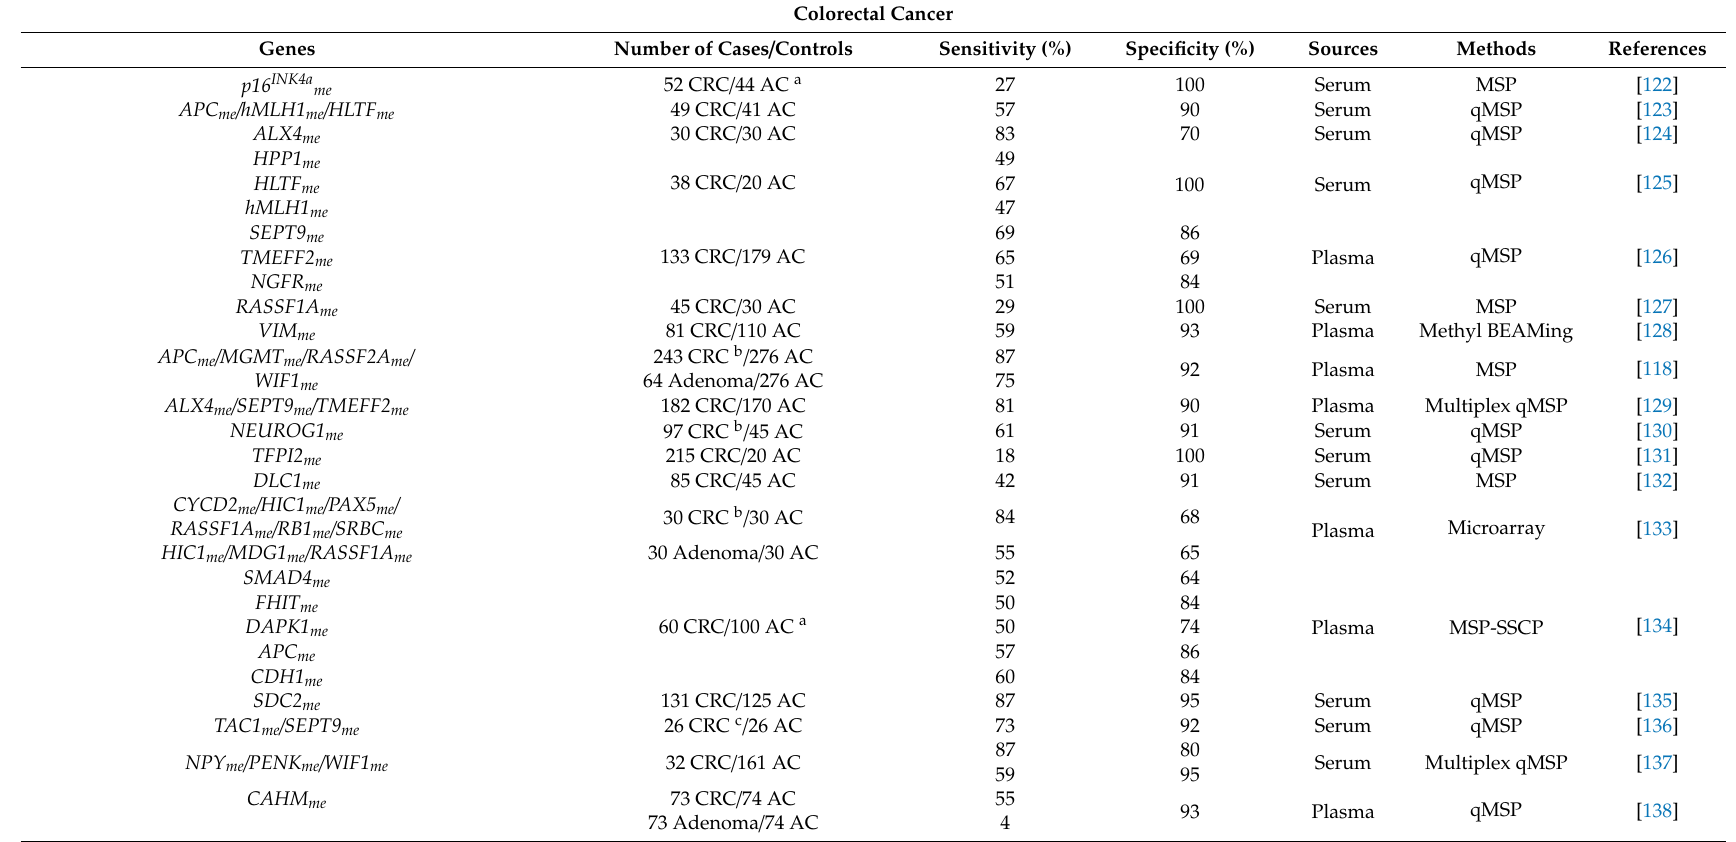
Table 3. CcfDNA-based methylation biomarkers for colorectal cancer (CRC)